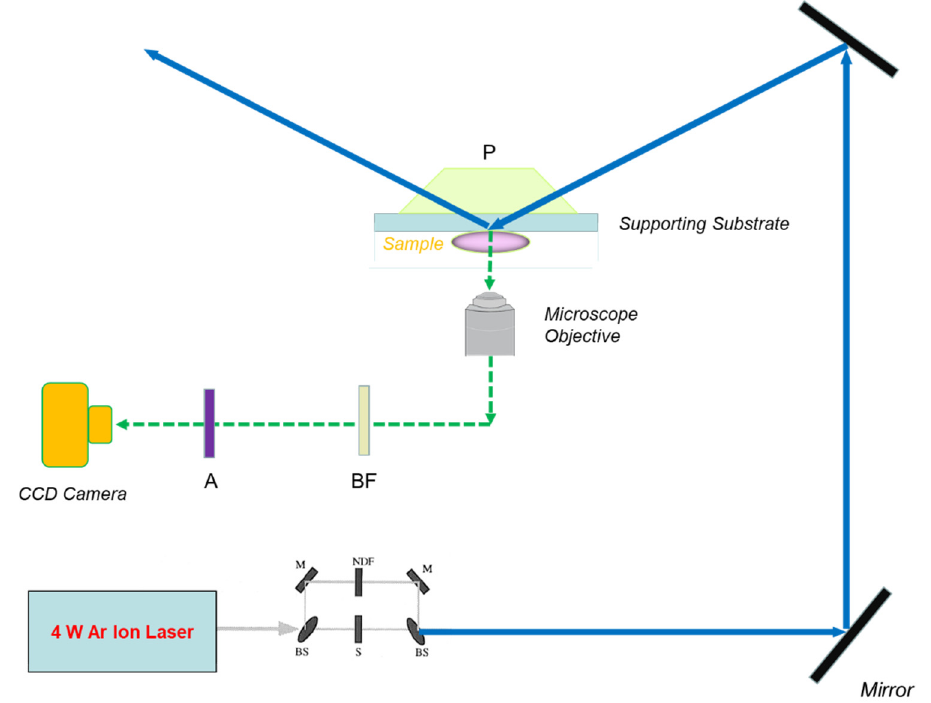
Figure 4. The overall optical train for the TIR/FRAP setup attached to an inverted microscope. The basic equipment is a 4 W argon ion laser, a low-light level-cooled CCD camera, an inverted microscope, and a computer for image capture and analysis. Beam Splitter: BS; Mirror: M; Dichroic Mirror: DM; Aperture: A; Prism: P; Shutter: S; Band Pass Filter: BF; Neutral Density Filler: